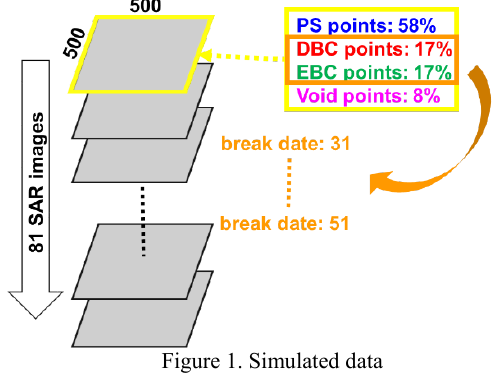
Figure 1. Simulated